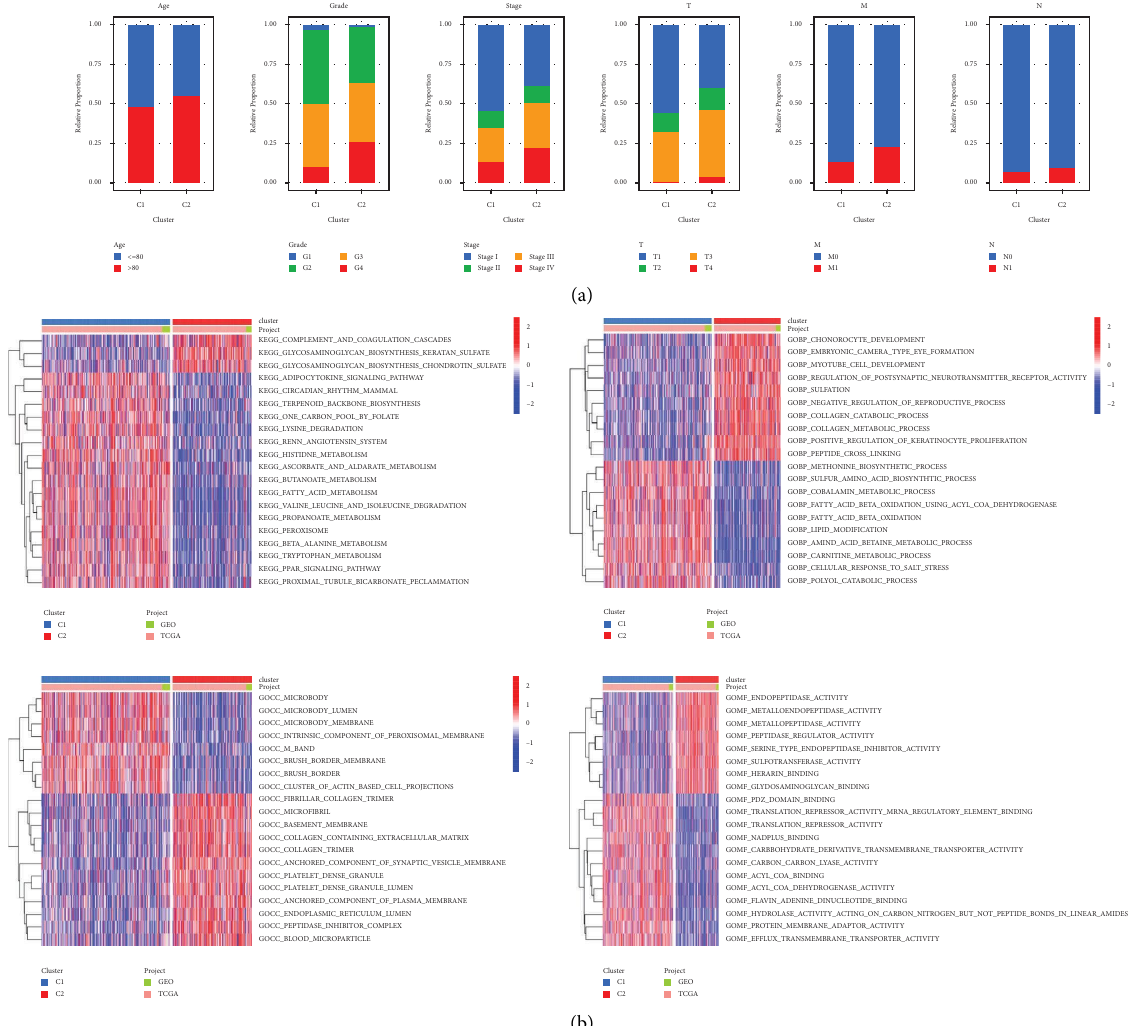
Figure 4: Comparisons of clinicopathological characteristics and diferentially analysis of enriched functions between 2 clusters: (a) stacked histograms of the proportion of clinicopathological characteristics and (b) heatmaps of the diverse functional